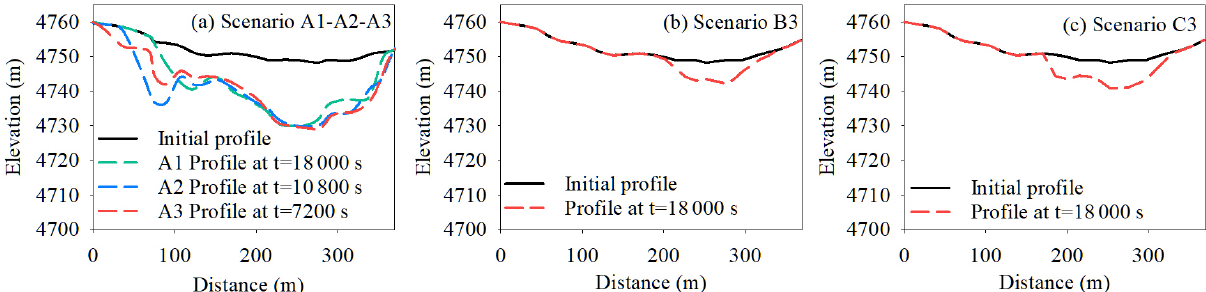
Figure 10. Erosion of the moraine dam under different conditions at the cross-section in Fig. 2g. Table 1. Calculated volume of Bienong Co based on published volume–area relationships for glacial lakes on the Tibetan Plateau. No. Source Relationships Calculated volume Error (%) 1 Qi et al.